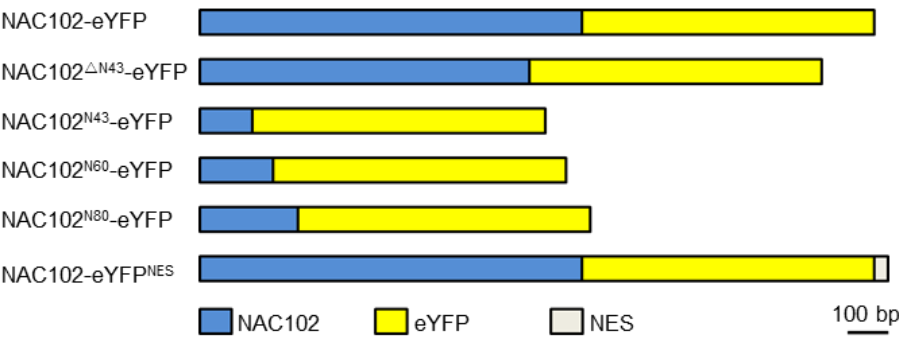
Figure 1. A schematic diagram of NAC102 fusion proteins.